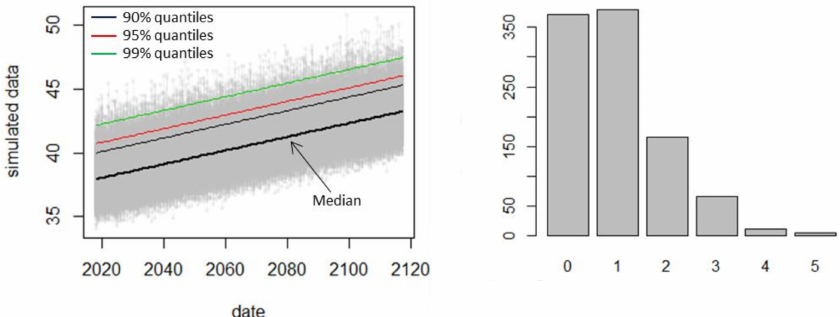
Figure 5. ( Left ) Simulated samples (using the parameters estimated from the observations) with 90%, 95%, and 99% quantiles; ( Right ) distribution of the number of exceedances over the integrated prediction during the period